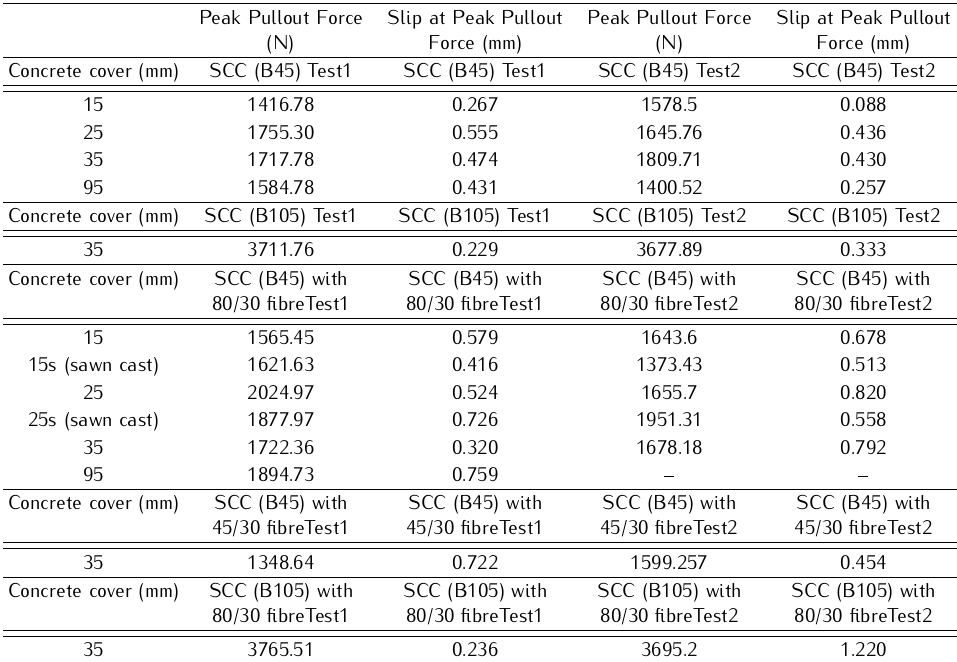
Table 5. Experimental results from the Schumacher